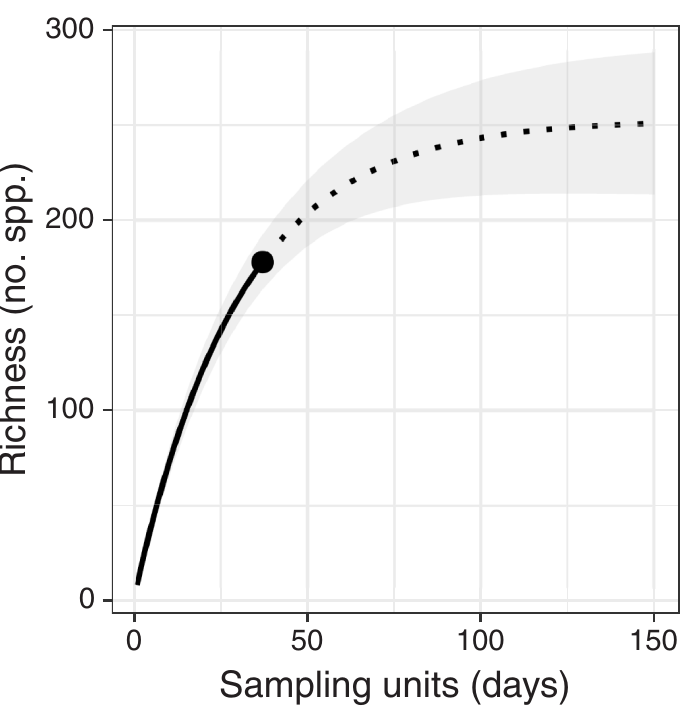
Fig 2. Interpolation (solid line) and extrapolation (dashed line) of species richness of pteridophytes at Nectandra Cloud Forest Reserve, Costa Rica. Point at transition from solid to dashed line indicates observed richness. Gray shading indicates 95% confidence